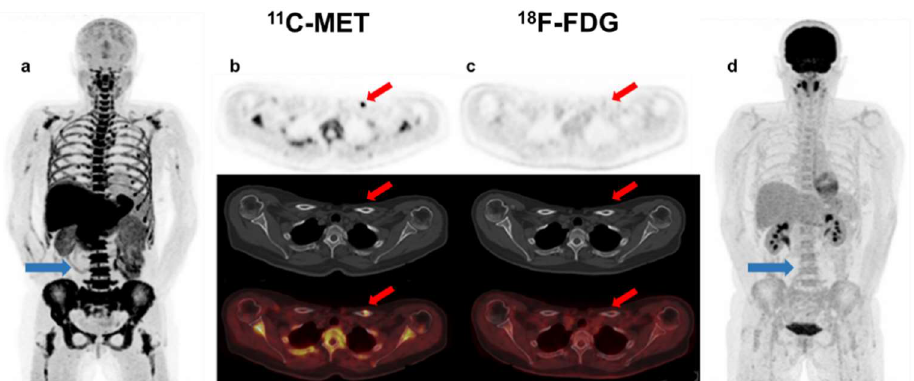
Figure 3. Patient with SMM with diffuse BM uptake (blue arrow-( a )) and FL without lytic component in the left clavicle (red arrow-( b )) in MET PET/CT (SUV max = 1.5). This finding could represent, despite being single, a focal active lesion of multiple myeloma. However, in FDG PET/CT, BM uptake was homogeneous and lower than in the liver (blue arrow-( d )), so inconclusive for malignant infiltration (anaemia?), while no focal uptake was observed in the clavicle (red arrow-( c )).